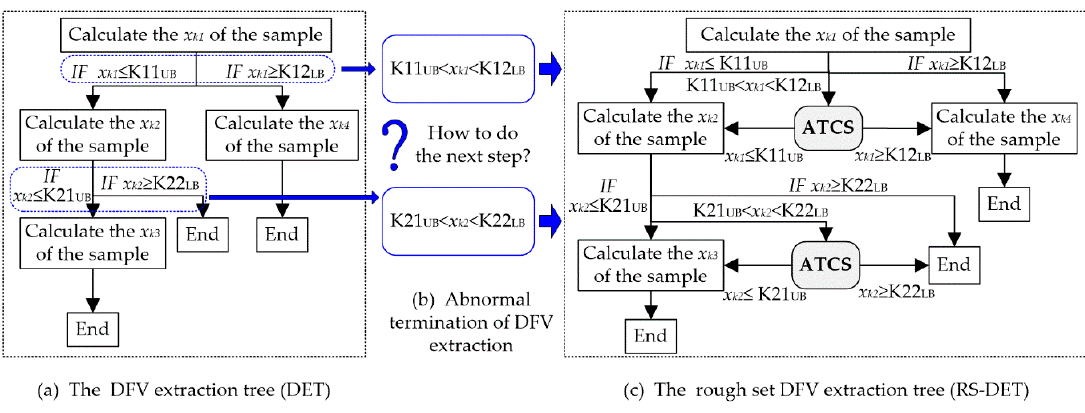
Figure 7. The RS-DFV extraction tree combining the rough set and DET (RS-DET).